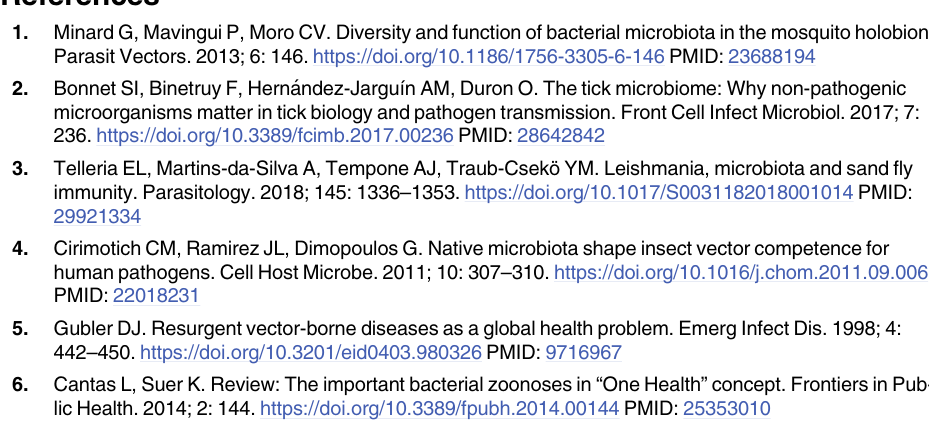
S4 Table. Results of PERMANOVA test for the comparison of bacterial OTU’s in pools of three Ixodid species between sampling methods based on unweighted UNIFRAC distances and 999 permutations. S5 Table. Results of PERMANOVA test for the comparison of bacterial communities in pools of three Culicoides species originating from the ground or canopy level collections based on UNIFRAC